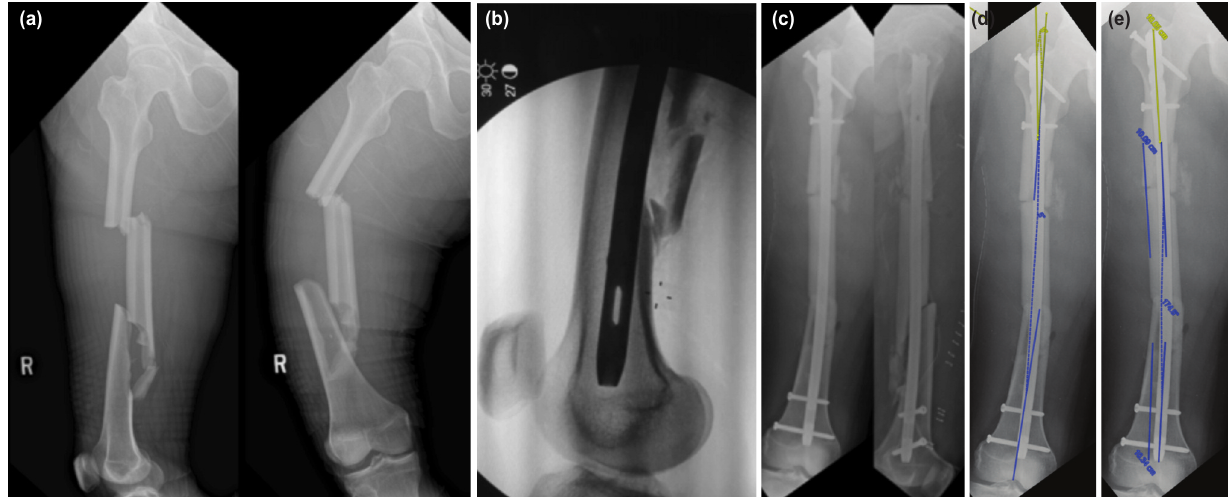
(a) Preop radiograph of right femoral segmental fracture, (b) Intraop fluoroscopic lateral knee view: two distal screws are Fig. 1: parallel with lateral knee axis, (c) immediate post op radiograph anterior posterior view and (d) lateral view, (e) 5° valgus